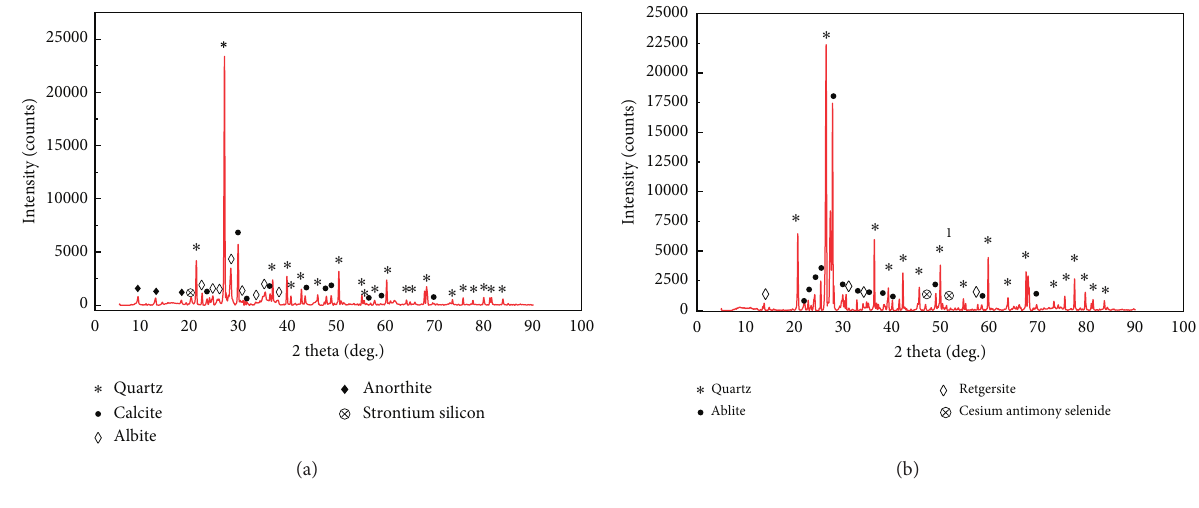
Figure 3: XRD patterns of test soils. (a) Loess. (b)